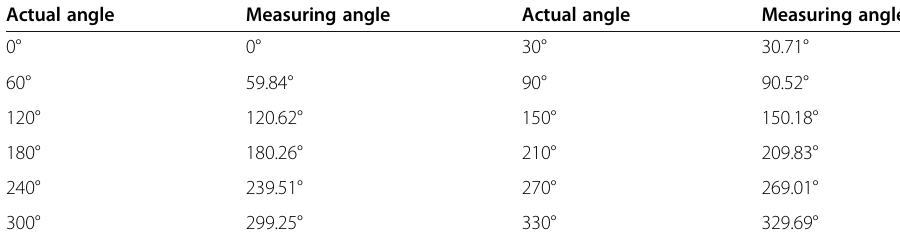
Table 3 Data processing effect of magnetoresistive sensor